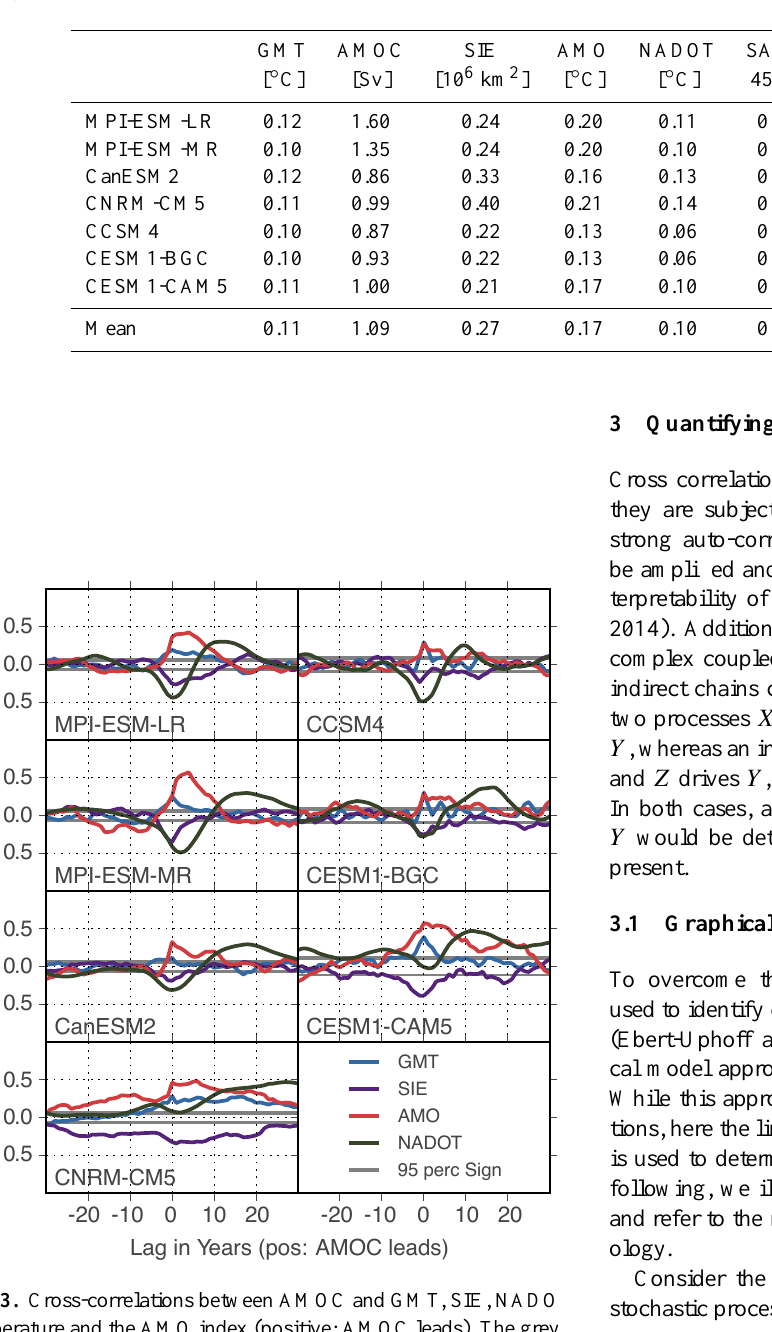
Table 2. Inter-annual variability (standard deviation) of GMT, AMOC, Northern Hemisphere sea-ice extent (SIE), AMO and North Atlantic deep ocean temperature (NADOT). SAT > 45 ◦ N denotes the explained GMT variance integrated over the Northern Hemisphere north of 45 ◦ N as in Fig. 3. OHC SD: standard deviation of the North Atlantic deep ocean (NADO) (45 ◦ to 65 ◦ N, z = 1000–2000m) heat content (OHC). OHC rate: maximum decadal trend over the full time series.